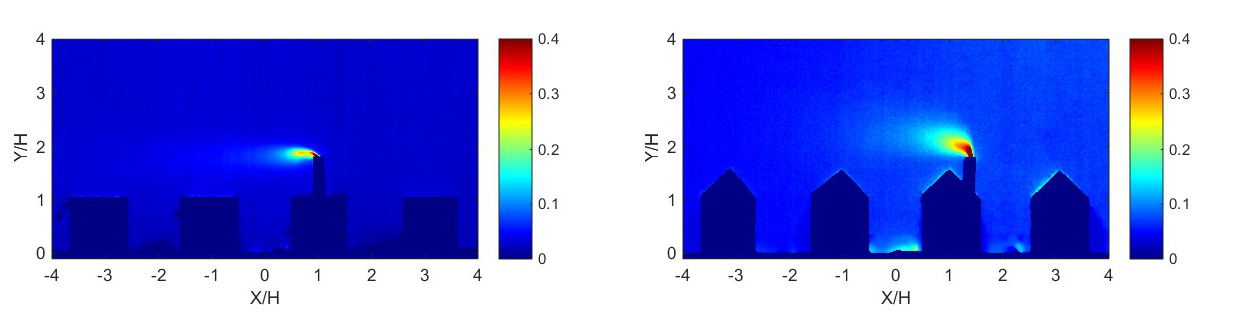
Fig. 11. Mean non-dimensional concentration C/C 0 field (C 0 is the mean concentration measured at the top of the chimneystack) for flat roof and a chimneystack (on the middle of the roof) with h/H = 0.75; the flow moves from the right to the left.